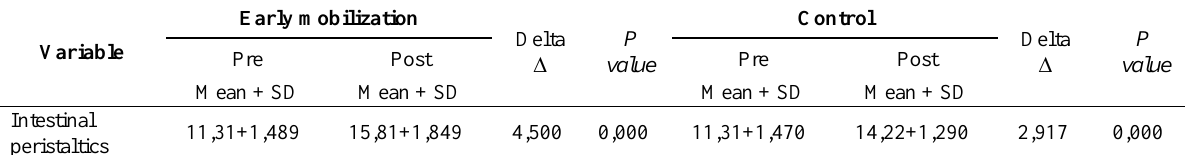
Table 2 Paired T-Test Test Effect of Early Mobilization on Increased Intestinal Peristalsis in Post-Cesarean Patients in Kendari City